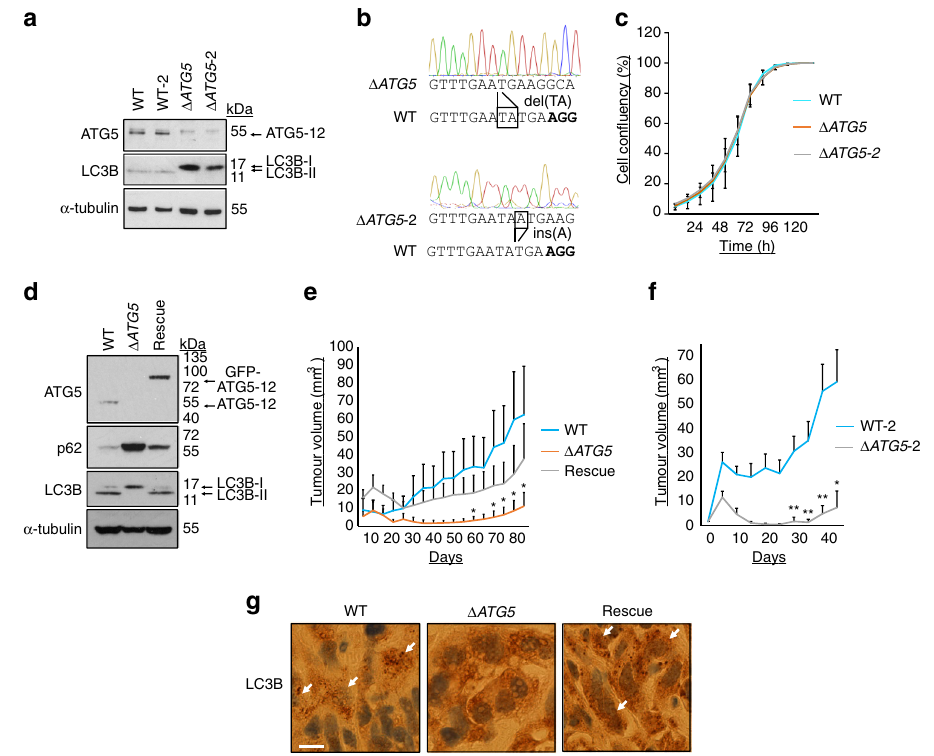
Fig. 1 Autophagy promotes tumorigenesis in vivo. a A549 cells de fi cient in ATG5 protein expression were generated by CRISPR/Cas9-mediated genome editing. Each of the two wild-type control clones (WT and WT-2) and Δ ATG5 clones ( Δ ATG5 and Δ ATG5 -2) were immunoblotted for the indicated proteins. b Genomic DNA from A549 Δ ATG5 and Δ ATG5 -2 cells was PCR ampli fi ed. The amplicon encompassed the sequence to which Cas9 had been targeted (PAM in bold ) and different indels were identi fi ed in both clones via Sanger sequencing. c A549 WT and Δ ATG5 cells were plated at low con fl uency for time-lapse phase-contrast videomicroscopy using an Incucyte microscope and cell proliferation was monitored by automated con fl uency analysis at set intervals post plating (means, n = 9 wells, ± S.D.). d A pooled derivative of Δ ATG5 cells was generated by stable transduction with GFP-ATG5 retrovirus (rescue). The indicated cell lines were immunoblotted as shown. e WT, Δ ATG5 and rescue cells were subcutaneously injected into immunocompromised mice and tumour volume was measured longitudinally (means, n = 10 fl anks, ± S.E.M., * P < 0.05 vs. WT, two-tailed t -test). f WT-2 and Δ ATG5 -2 cells were compared for tumour growth after subcutaneous injection into immunocompromised mice (means, n = 12 fl anks, ± S.E.M., * P < 0.05 or ** P < 0.01 vs. WT-2, two-tailed t -test). g At the end of tumour growth in e , control tumours and suf fi ciently large Δ ATG5 tumours were fi xed and stained for LC3B via immunohistochemistry (DAB stain, arrows indicate regions of LC3B puncta, scale bar = 10 µ m). Representative images are shown here. Uncropped blots are available in Supplementary Fig.